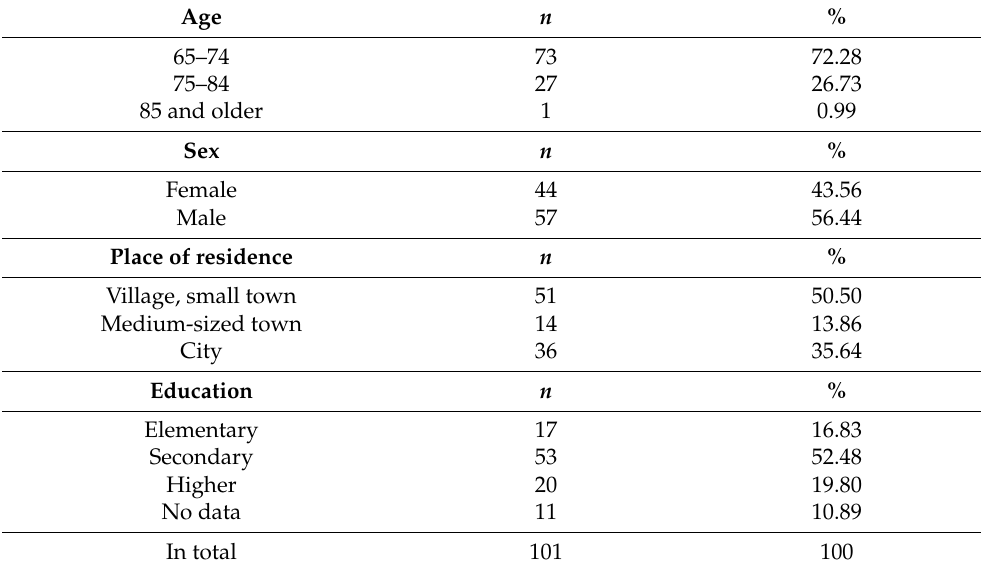
Table 1. Characteristics of the study